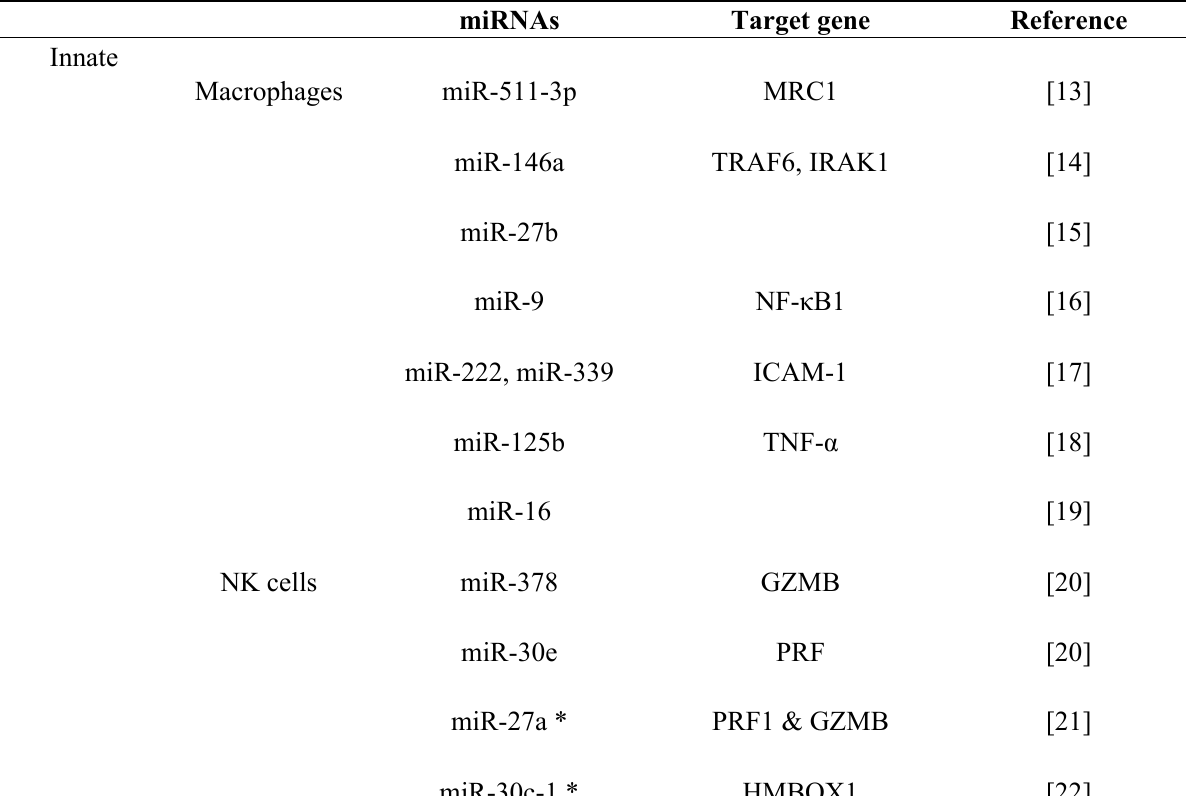
Table 1. miRNAs involved in innate